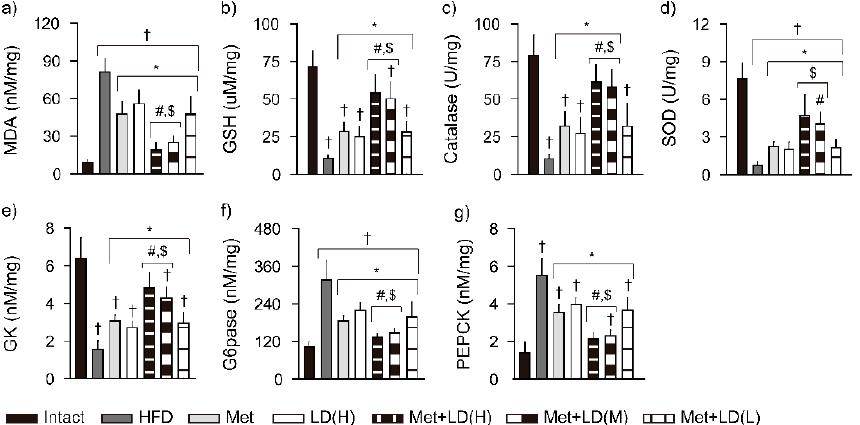
Figure 5. Combination effects on hepatic antioxidant defense system and glucose regulation. ( a – d ) Levels of malondialdehyde (MDA) and glutathione (GSH), activities of catalase and superoxide dismutase (SOD). ( e – g ) Glucose-regulating enzyme activities of glucokinase (GK), glucose-6-phosphatase (G6pase), and phosphoenolpyruvate carboxykinase (PEPCK). Values are represented as the means ± SDs ( n = 8). †, *, #, and $: p < 0.05 vs. the Intact, HFD control (HFD), Met, and LD(H) groups,